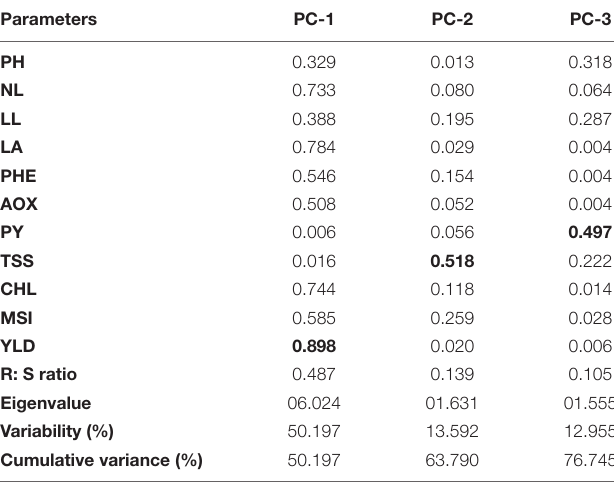
TABLE 12 | Rotated component matrix for principal components of 12 traits of 12 contrasting onion genotypes evaluated under waterlogging condition.